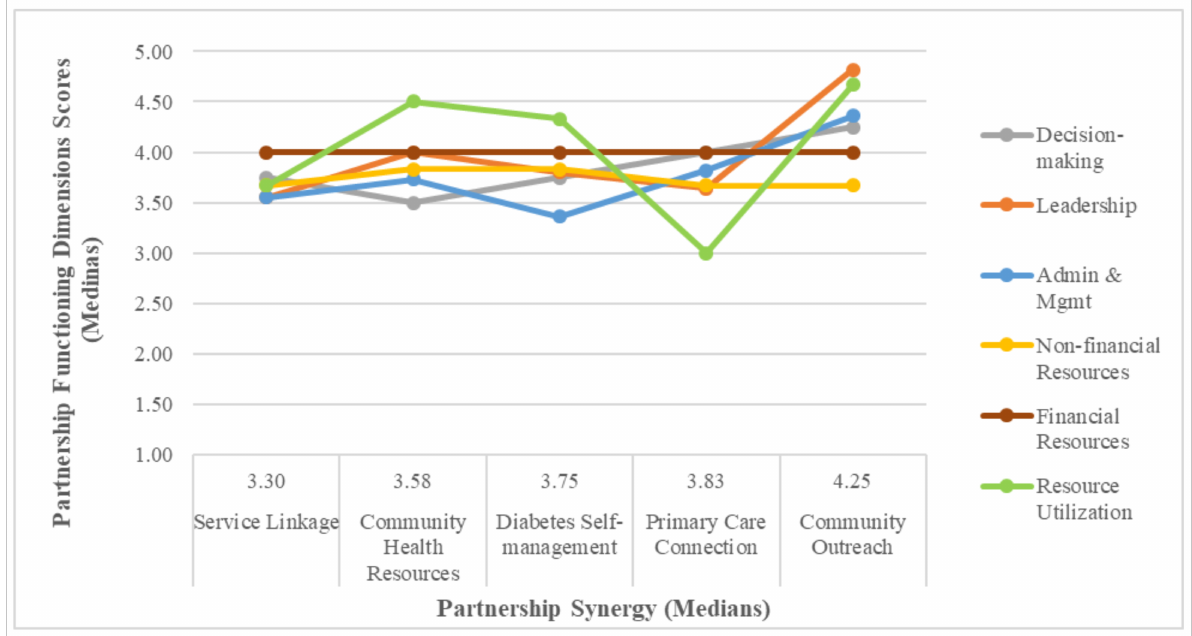
Figure 2. Comparison of values of partnership assets, processes and total partnership synergy by partnership ( n = 5) (reproduced from